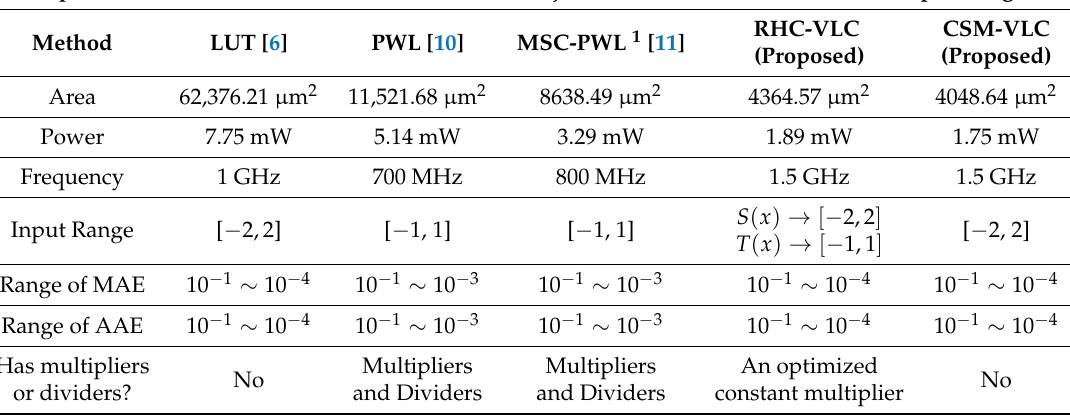
Table 8. Hardware Performance Comparison Between Our Methods and Existing